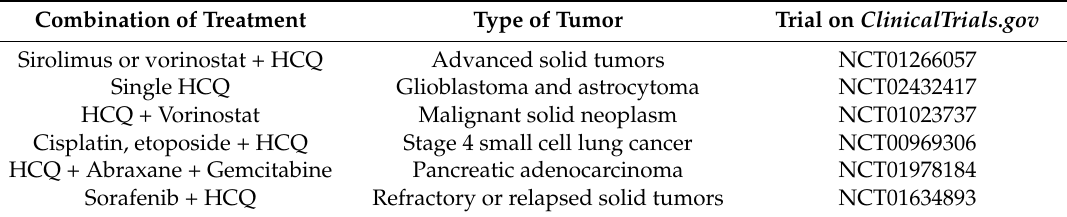
Table 3. List of some clinical trials of hydroxychloroquine.